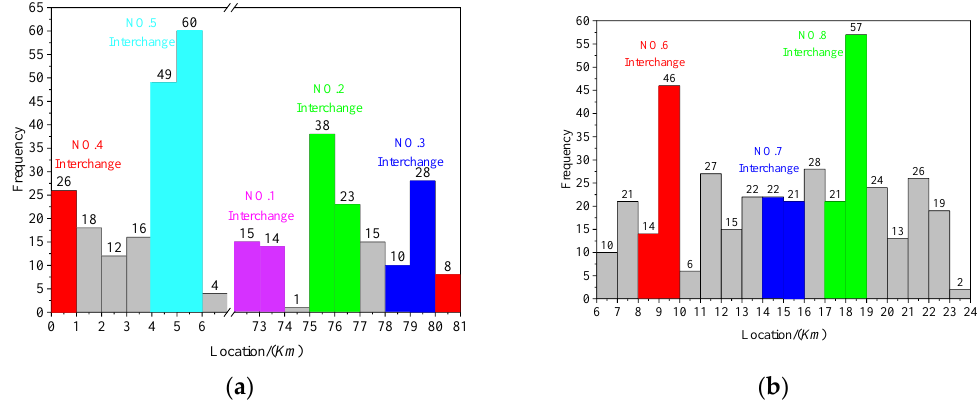
Figure 5. ( a ) Accident mileage distribution in Section Ⅰ ; ( b ) Accident mileage distribution in Section Ⅱ .